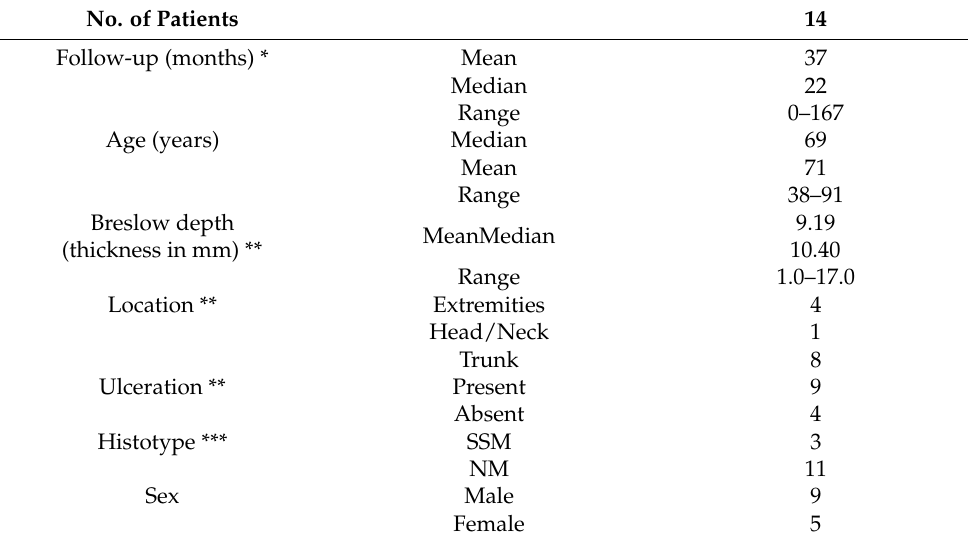
Table 2. Clinicopathologic summary of melanoma patients with primary tumors with